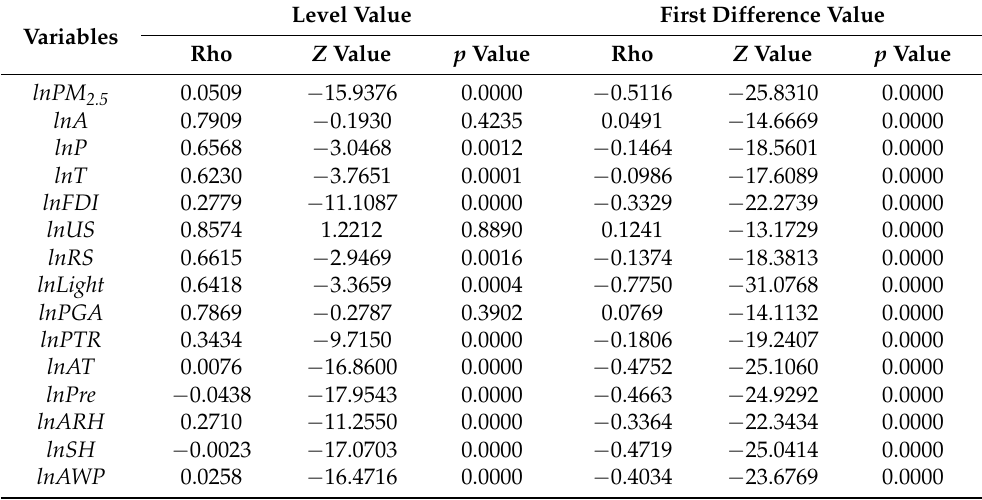
Table 2. Unit root test.